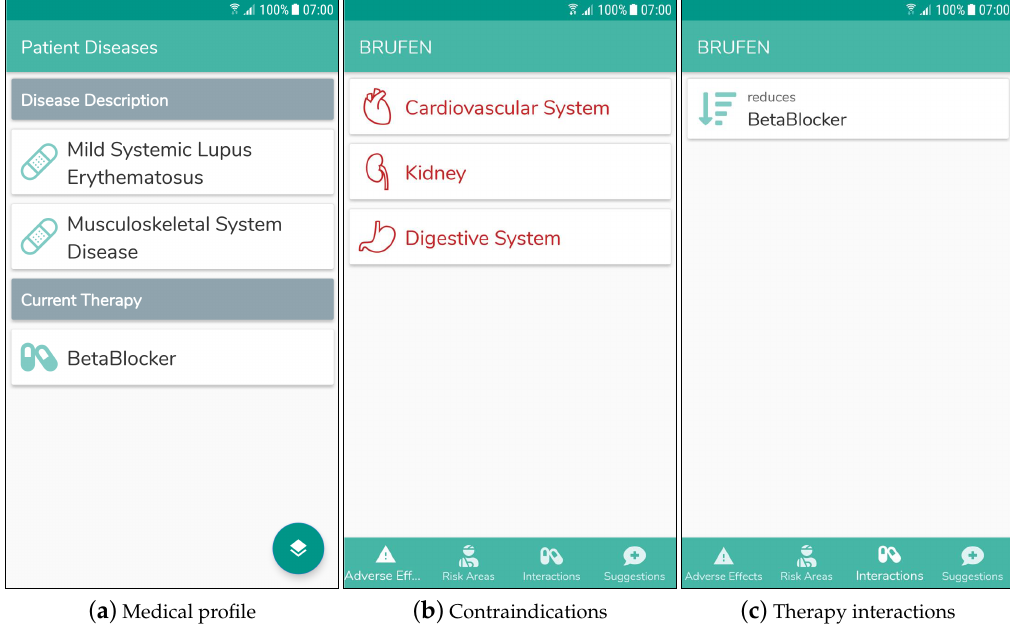
Figure 9. Screenshots of the mobile DSS user interface for Example